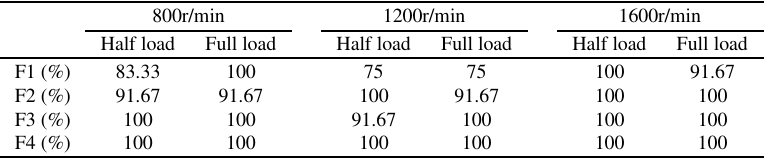
Table 7 The classification success rate with the vertical vibration signal analysis